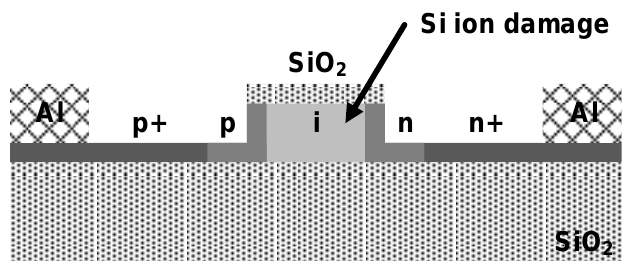
Figure 18. Cross-sectional view of waveguide PD [58].